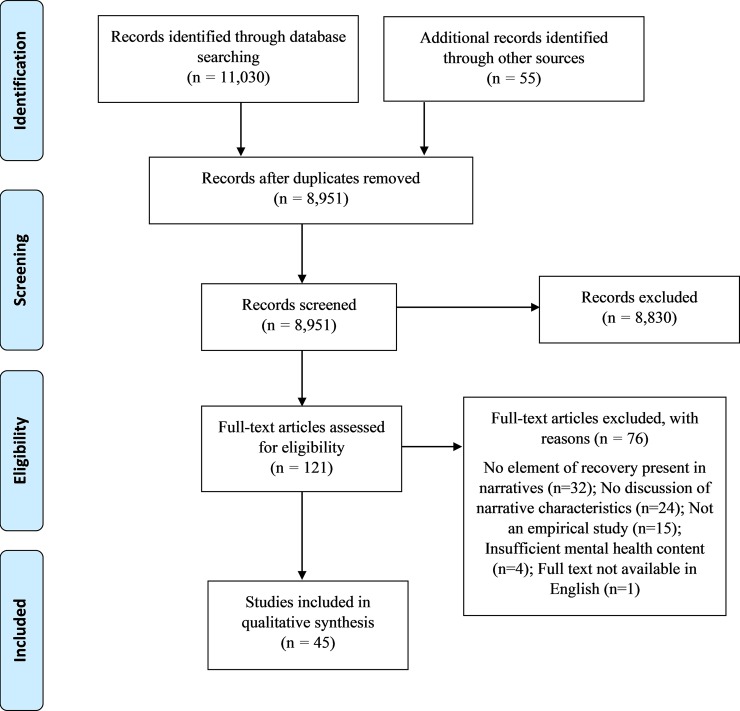
PRISMA flow diagram.